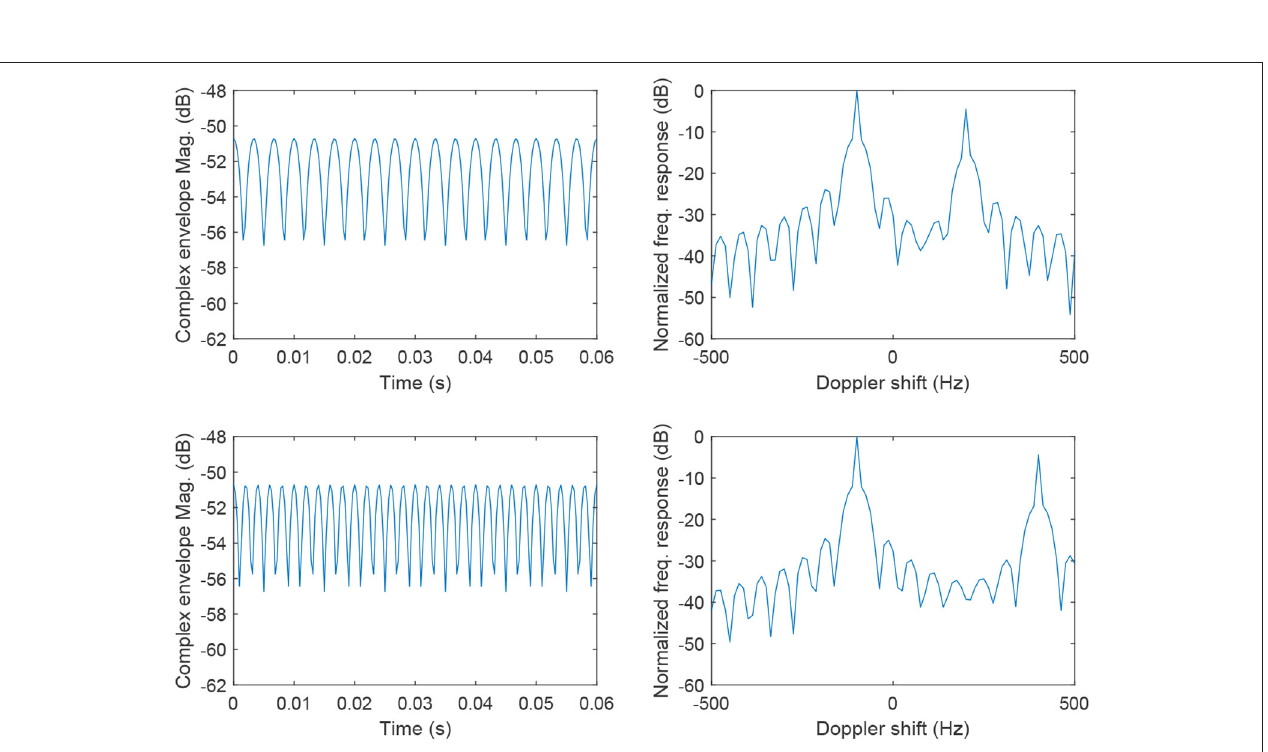
FIGURE 6 | Time varying magnitude and the Doppler spectrum of the received signal with increased Doppler effect for (Top) ˜ f D = 200 Hz and (Bottom) ˜ f D = 400 Hz.